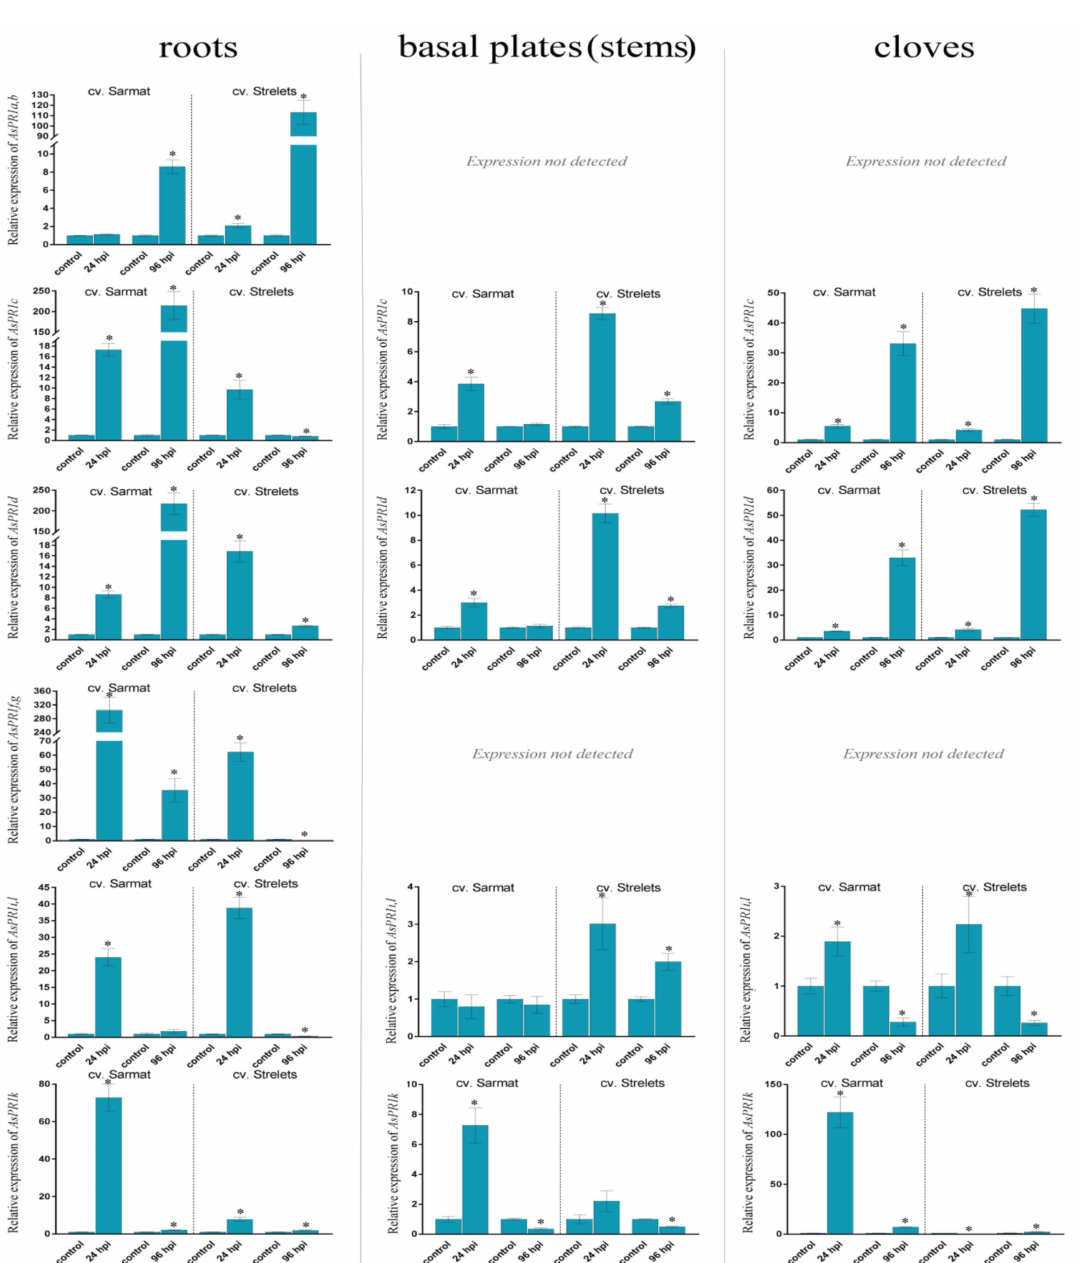
Figure 3. Transcription of the AsPR1a(b) , AsPR1c , AsPR1d , AsPR1f(g) , AsPR1i(l) , and AsPR1k genes in Allium sativum cv. Sarmat (FBR-resistant) and Strelets (FBR-susceptible) in response to Fusarium proliferatum infection. The plants were incubated with F. proliferatum conidia and analyzed for mRNA levels in the roots, stems, and cloves at 24 and 96 hpi by qRT-PCR. The data were normalized to GAPDH and UBQ mRNA levels and presented as fold change (mean ± SE) of the control taken as 1; * p < 0.01, compared to the uninfected